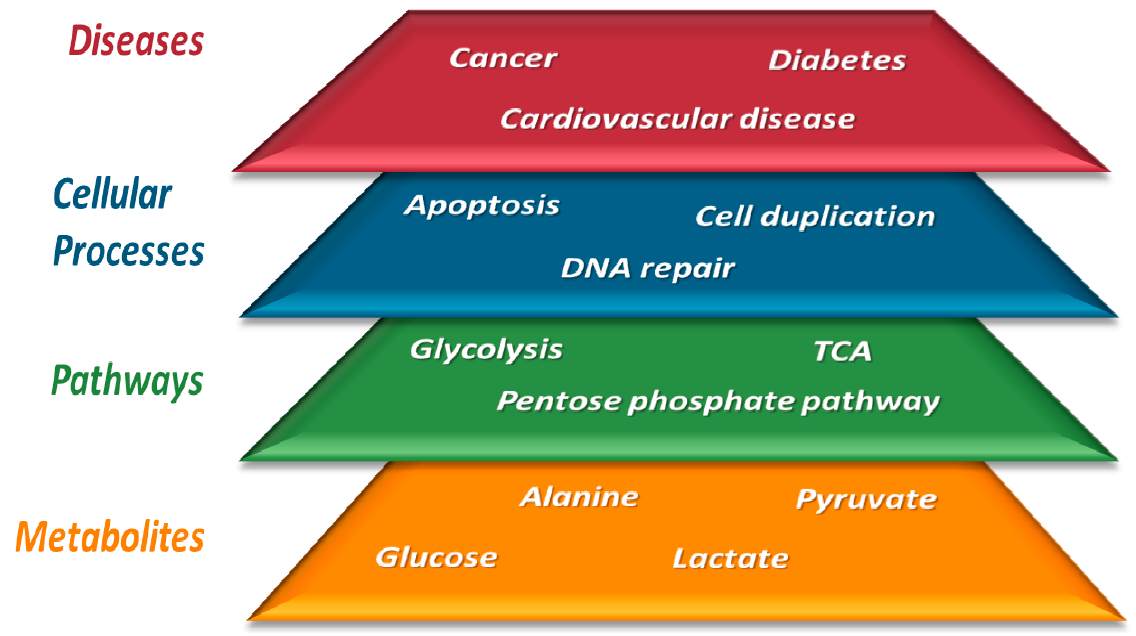
Figure 3. The four layers that make up metabolomics research: from studying metabolites to trying to understand pathological states. to understand pathological